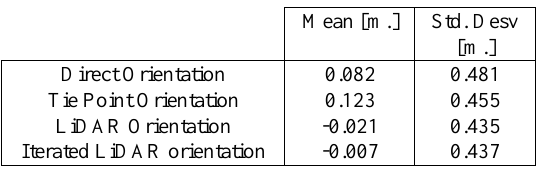
Table 2: 2010 Statical Evolution